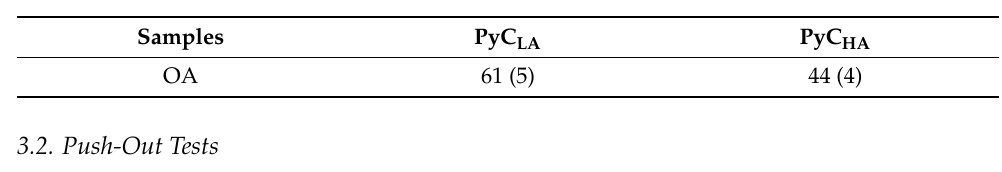
Figure 4. HRTEM (002) lattice fringes micrographs of the as-processed pyrocarbon: ( a ) PyC LA and ( b ) PyC HA . Table 4. OA of processed pyrocarbon. () standard